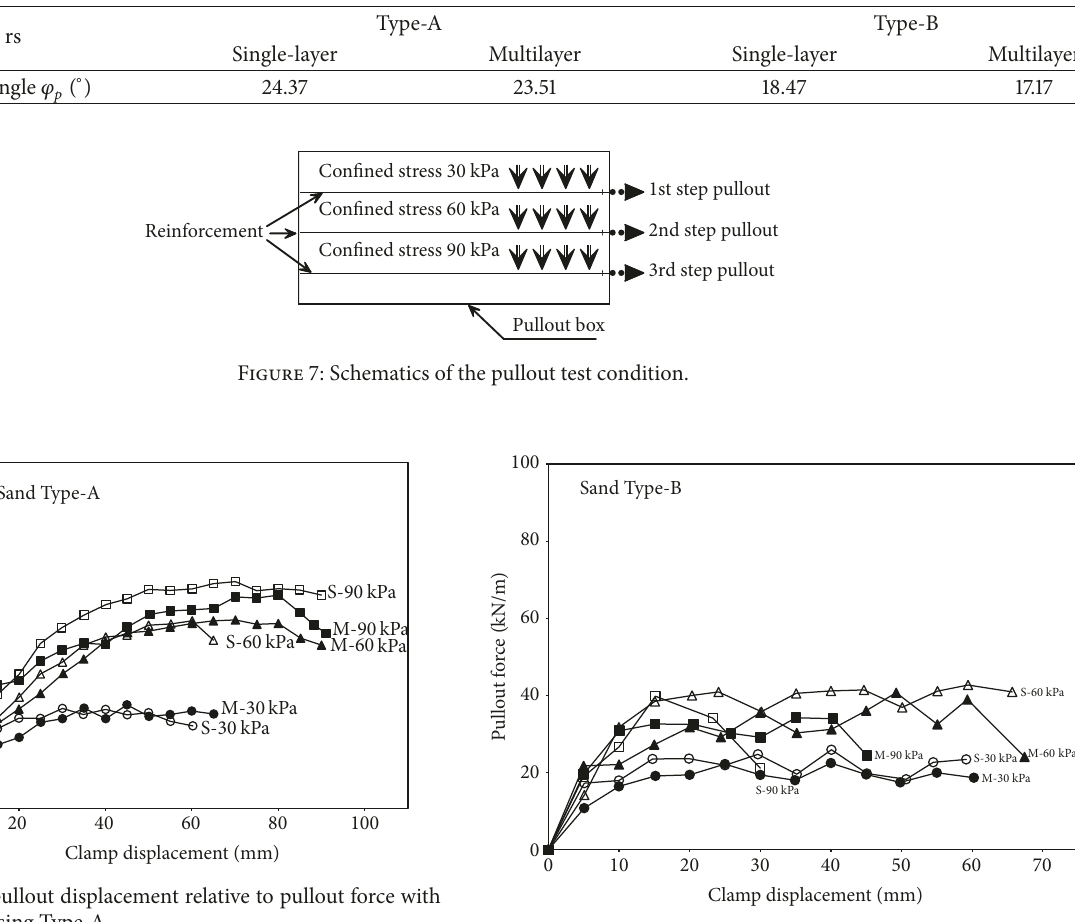
Figure 9: Front pullout displacement relative to pullout force with confining stress using